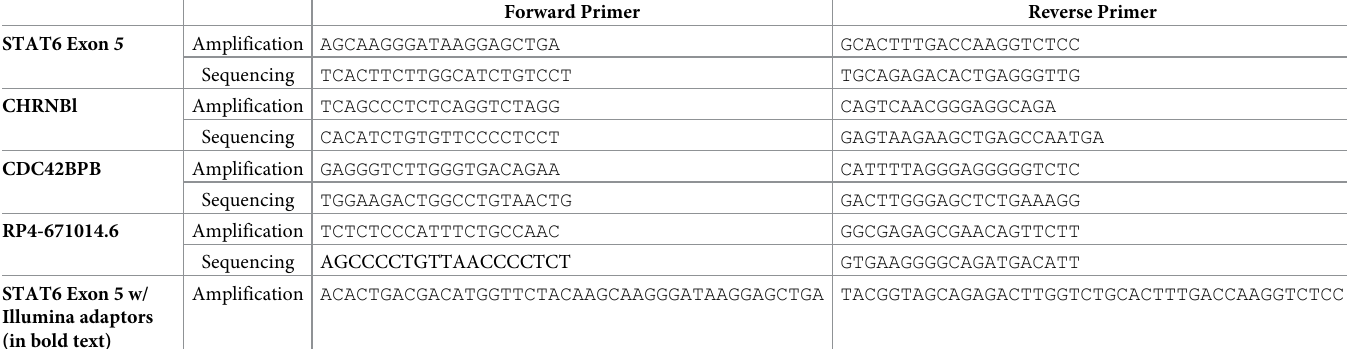
Table 3. Amplifying and sequencing